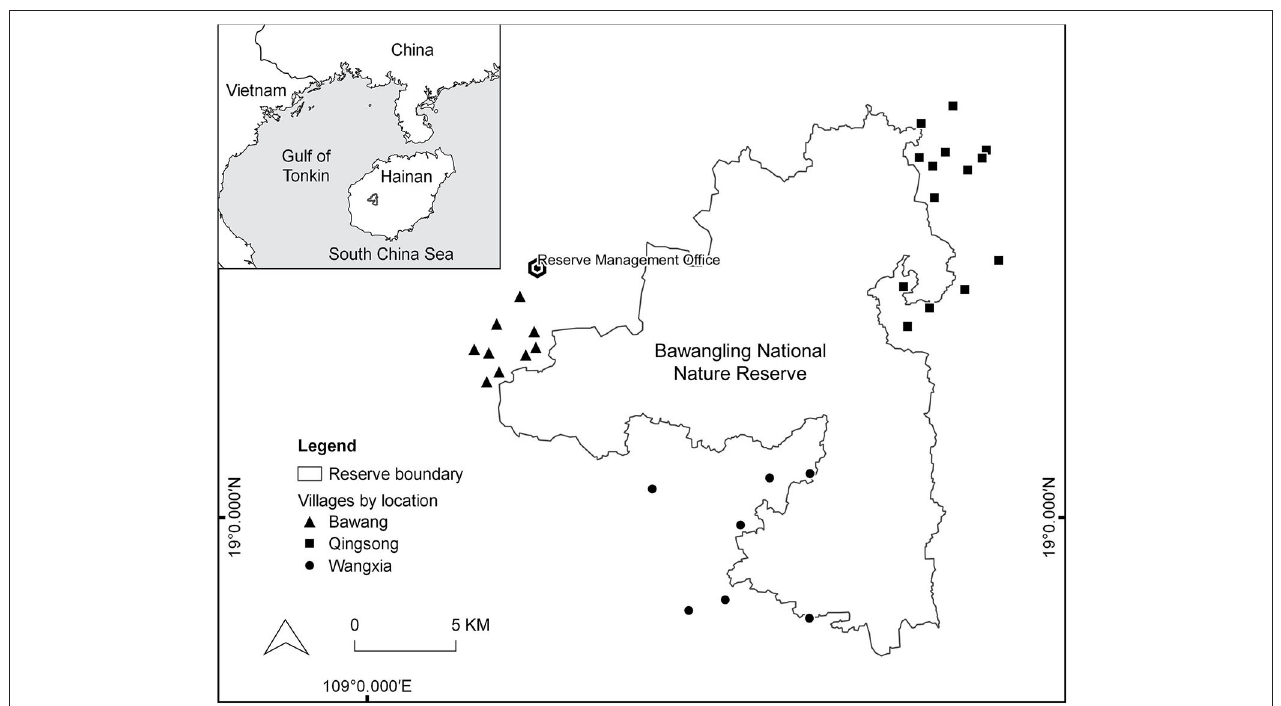
FIGURE 1 | Villages visited in this survey around Bawangling National Nature Reserve in western Hainan,